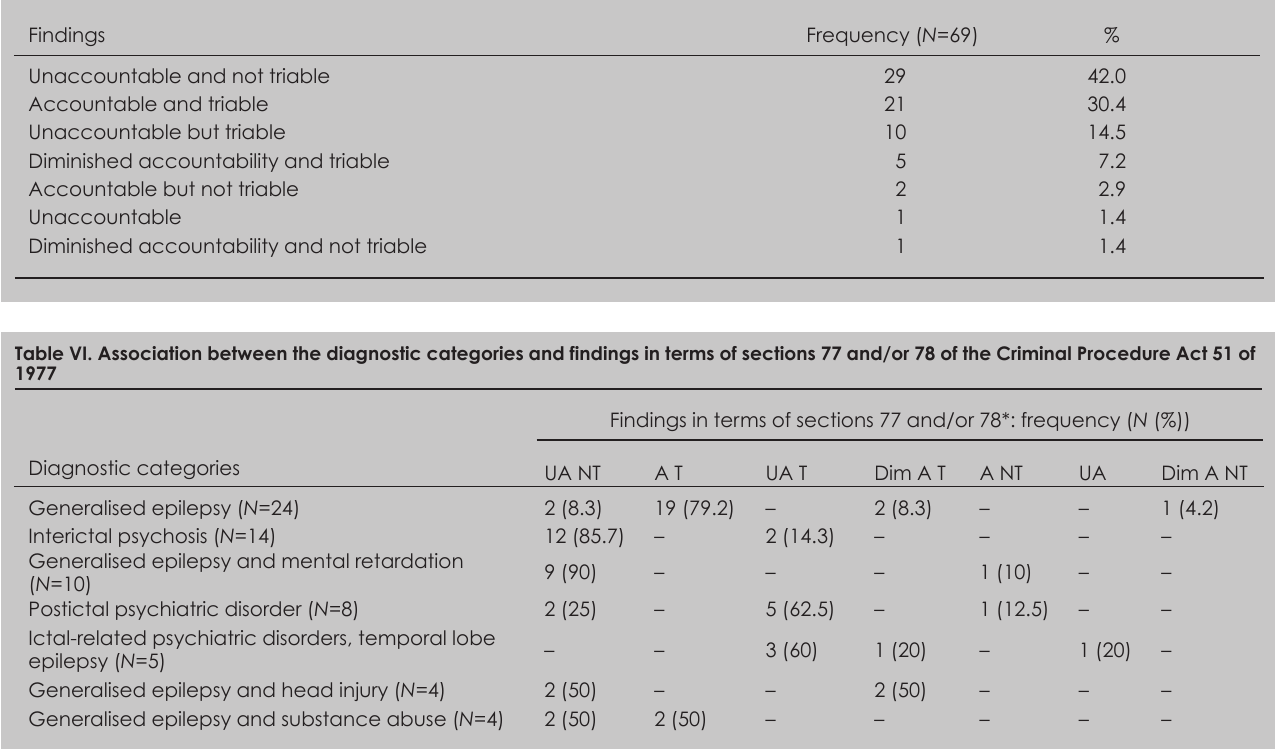
Table V. Findings in terms of sections 77 and/or 78 of the Criminal Procedure Act 51 of 1977 Findings